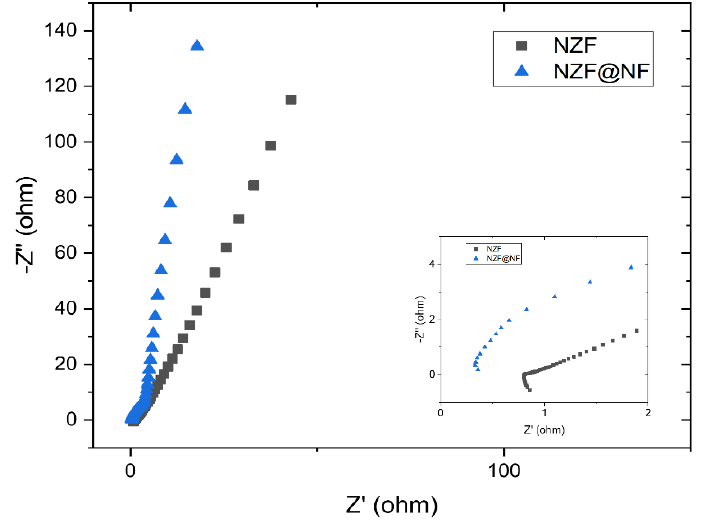
Figure 6. ( a ) GCD curves of NZF in the potential window of − 0.5 to 0.4 V; ( b ) GCD curves of NZF in the potential window of − 0.5 to 0.4 V; ( c ) Ragone plot of the specific capacity as a function of the current density; ( d ) Ragone plot of the energy density and power density. Table 1. Comparison of specific capacitance with the earlier reported literature.